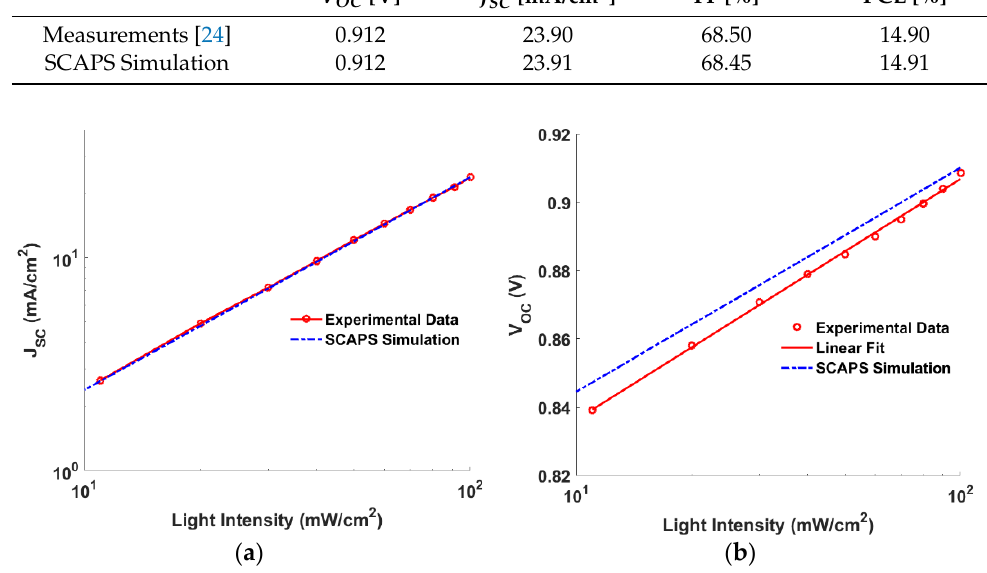
Figure 3. Variation of ( a ) J sc and ( b ) V oc on light intensity for both experimental and calculated data.